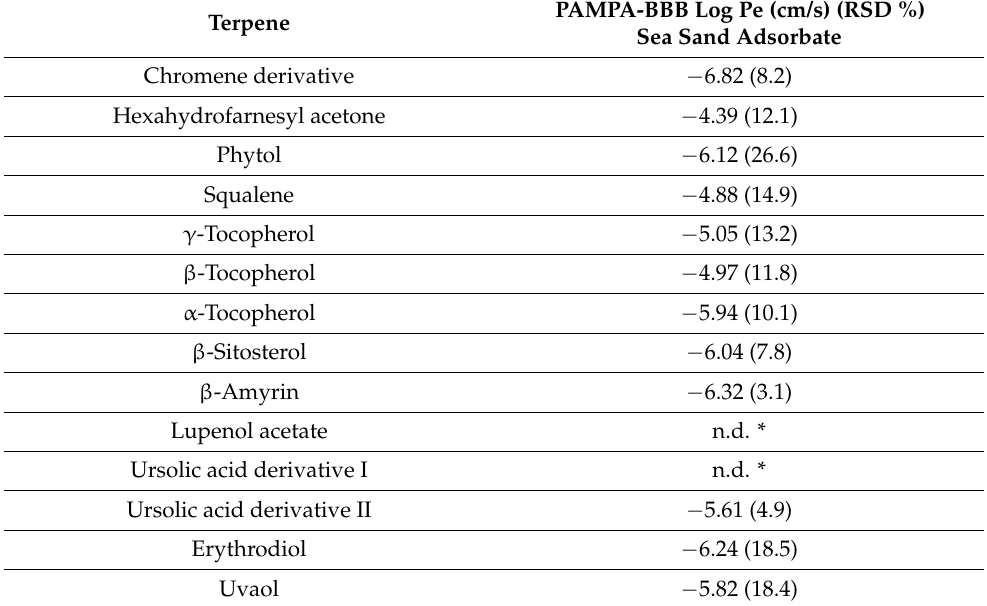
Table 5. Main terpenes from SS adsorbate identified in PAMPA-BBB